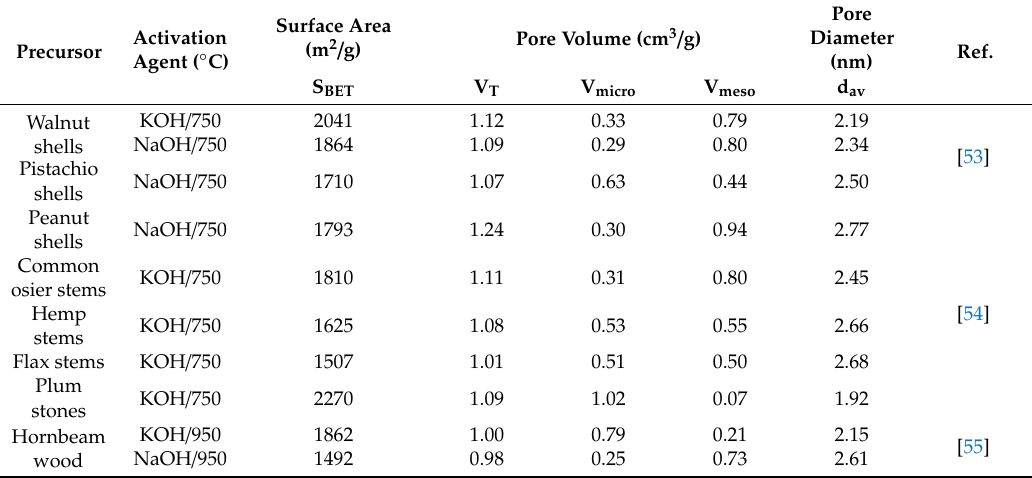
Table 7. Parameters of porous structure of chemically activated carbons derived from di ff erent